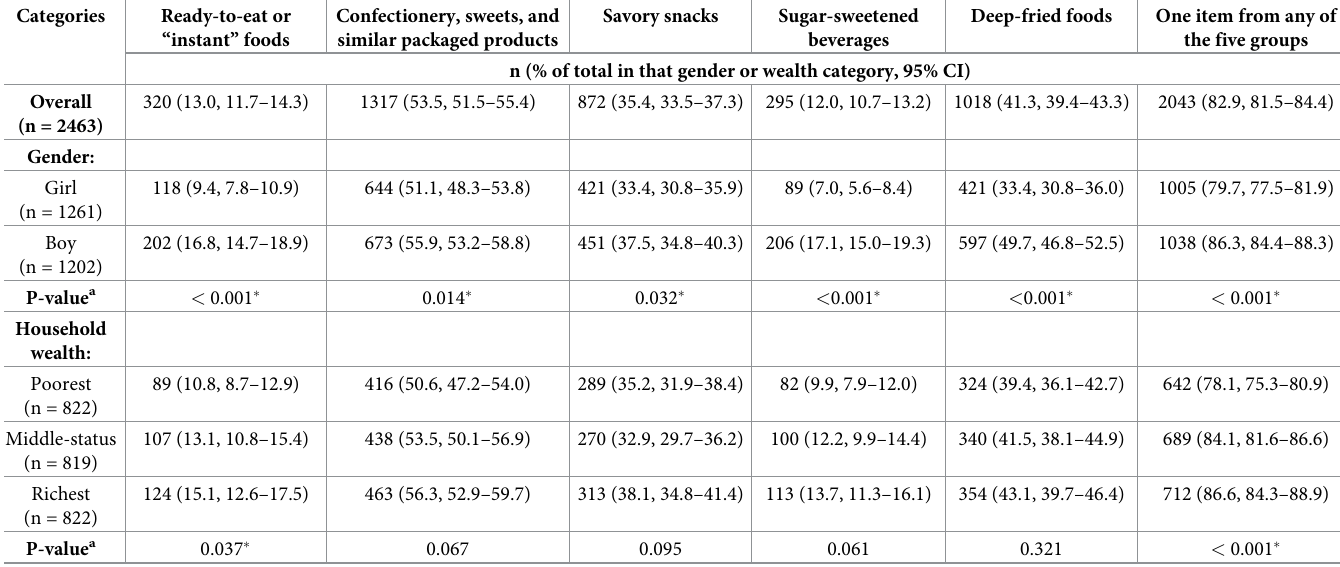
Table 2. Prevalence of consumption of ultra-processed and deep-fried foods among the adolescents by gender and wealth